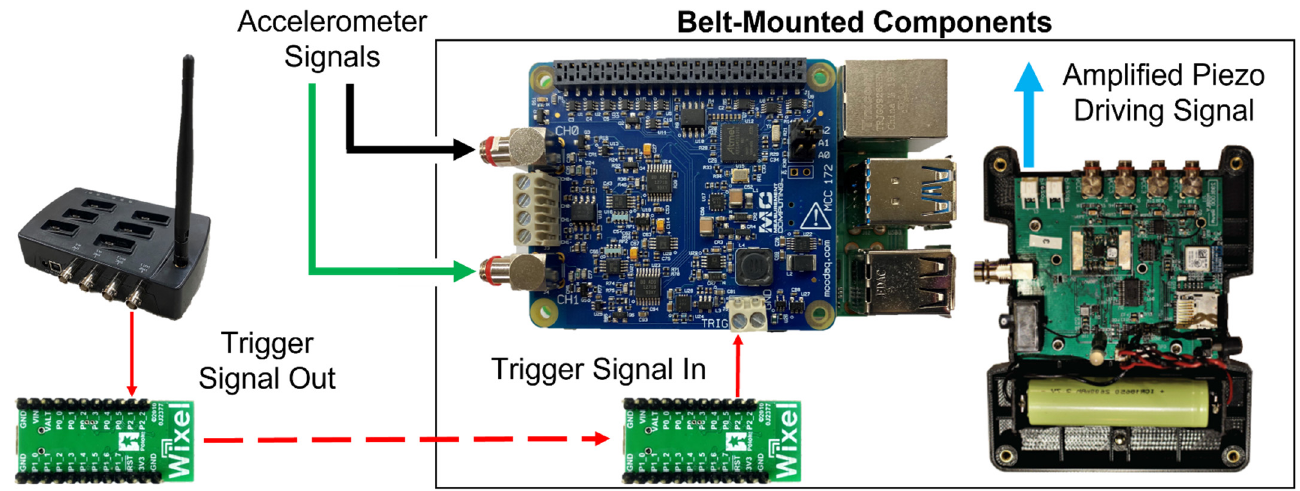
Figure 1. Synchronization signals were delivered wirelessly from the XSens MVN Awinda Station (left) via Pololu Wixels to the tensiometer’s MCC 172 DAQ HAT trigger pin (center) [63–65]. Participants wore a belt to accommodate these components for driving the tapper and recording the accelerometer data.